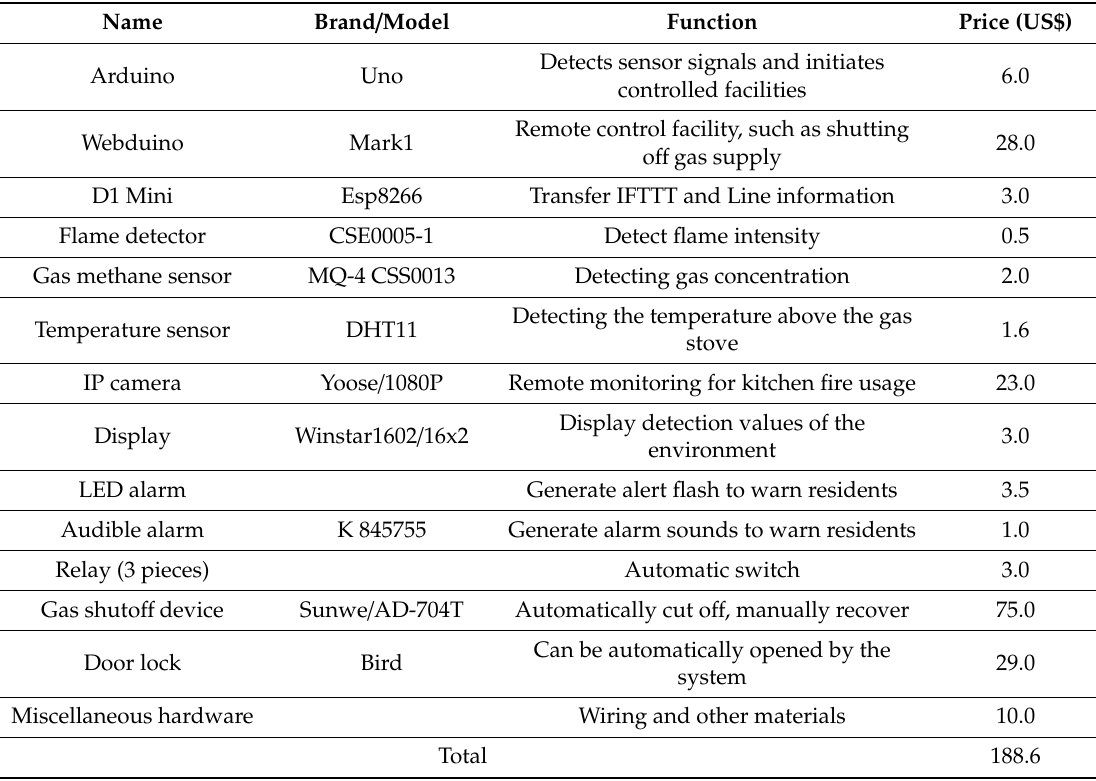
Table 2. The hardware used in this